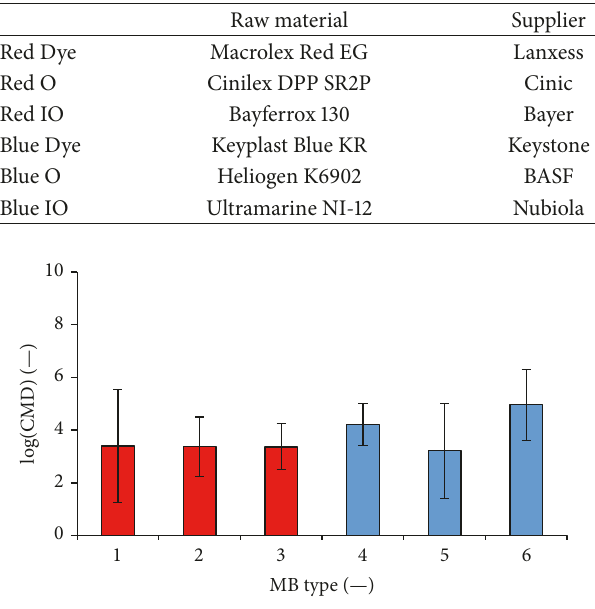
Figure 4: Inhomogeneity scores of the tested masterbatches in the first test series (1: Red Dye; 2: Red Organic; 3: Red Inorganic; 4: Blue Dye; 5: Blue Organic; 6: Blue